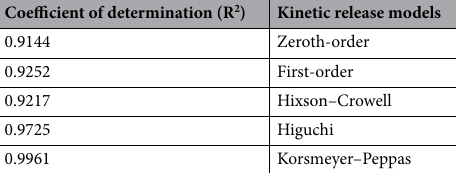
Coefficient of determination (R 2